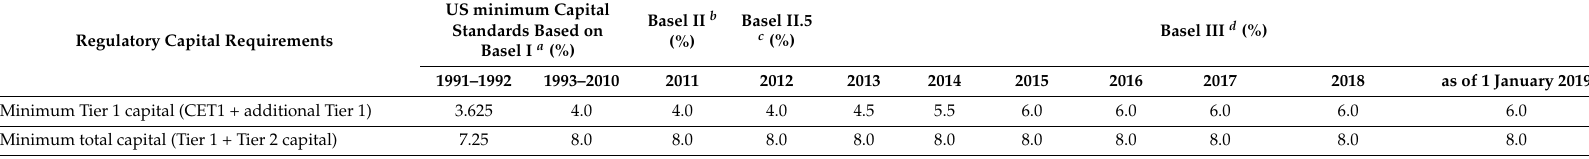
Table 3. A Timeline of United States (US) Capital